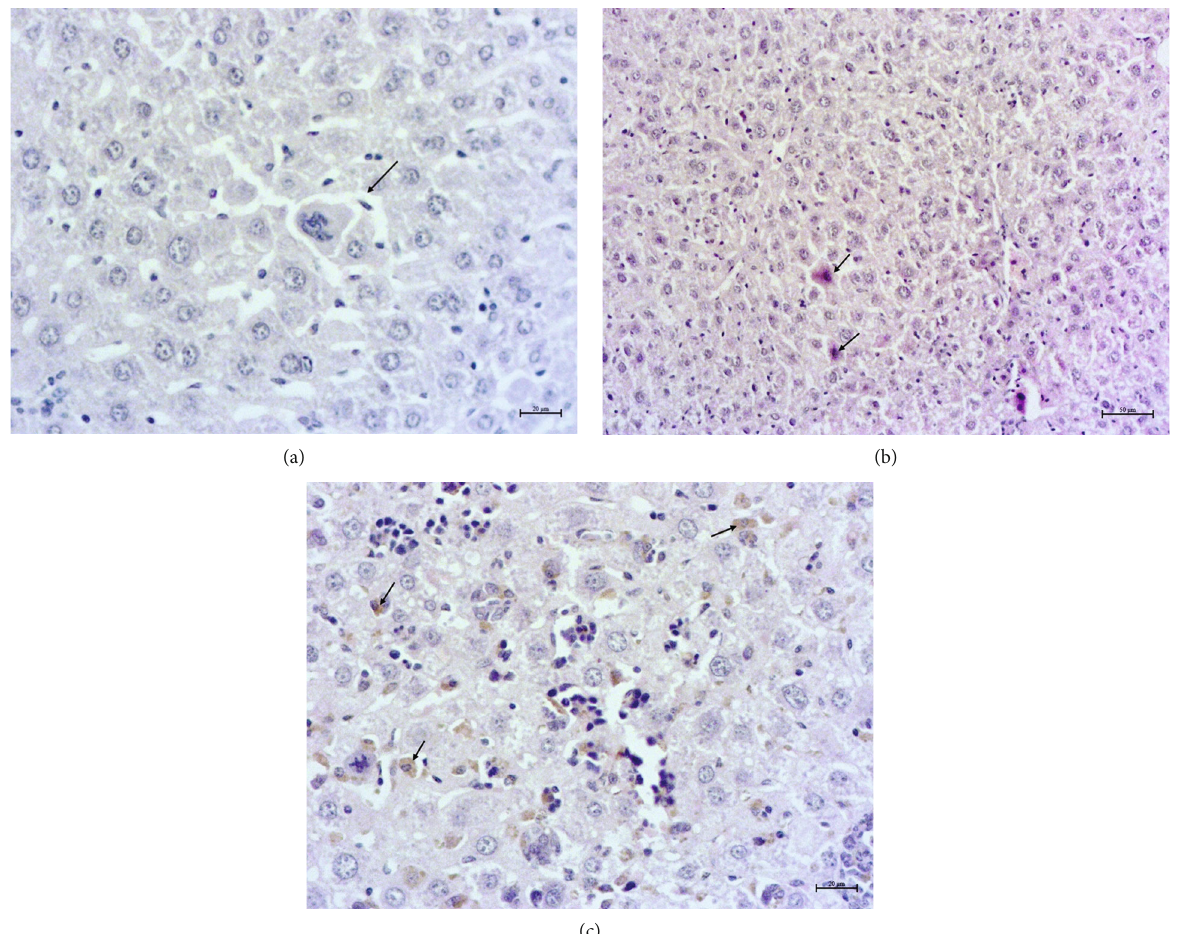
Figure 5: Intrahepatocellular edema (a) and acidophil bodies (b) (arrows) in the samples of daytime-feeding untreated animals. Pigmented macrophages (c) in the sample of liver of daytime-feeding PG at 7 AM animals. H&E staining; mg. × 400, × 200, and ×